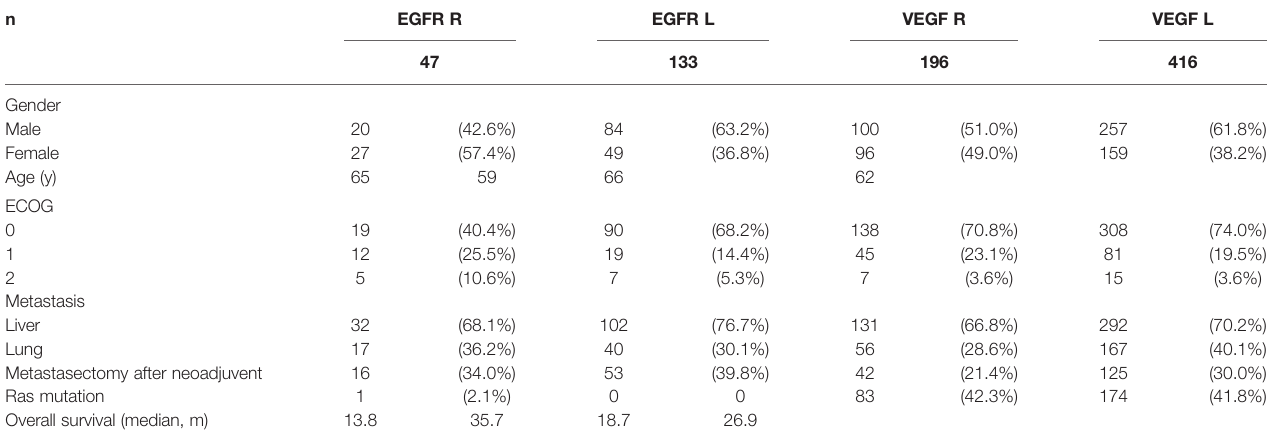
TABLE 2 | The patients ’ characteristics in the groups by different tumor location and target